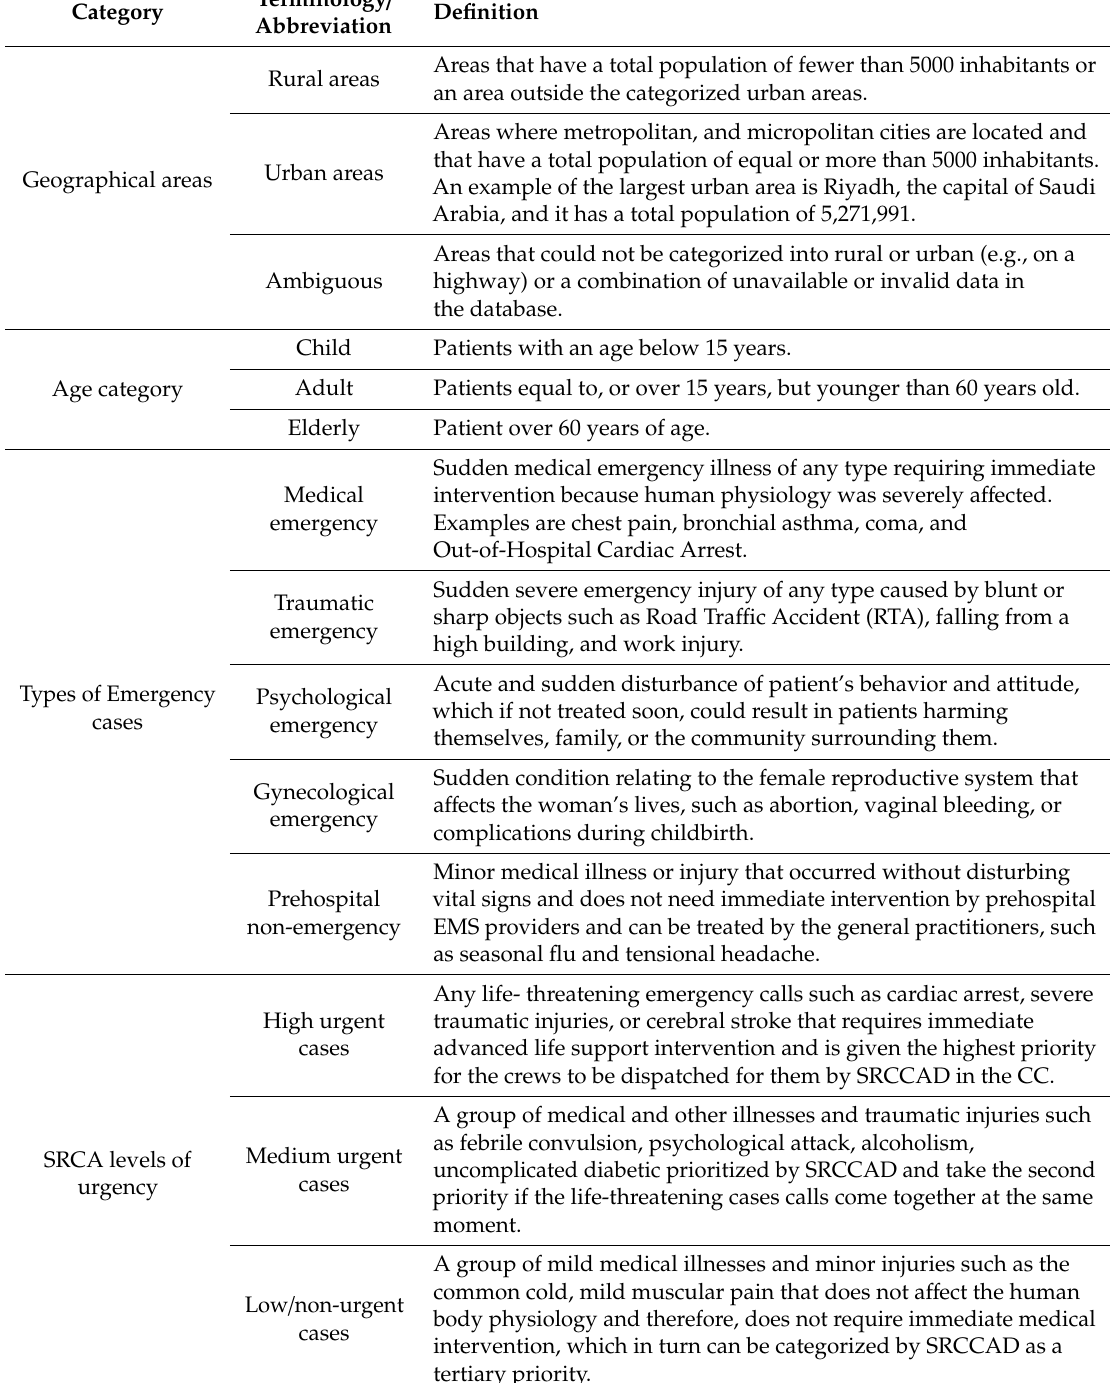
Table 1. Definitions and